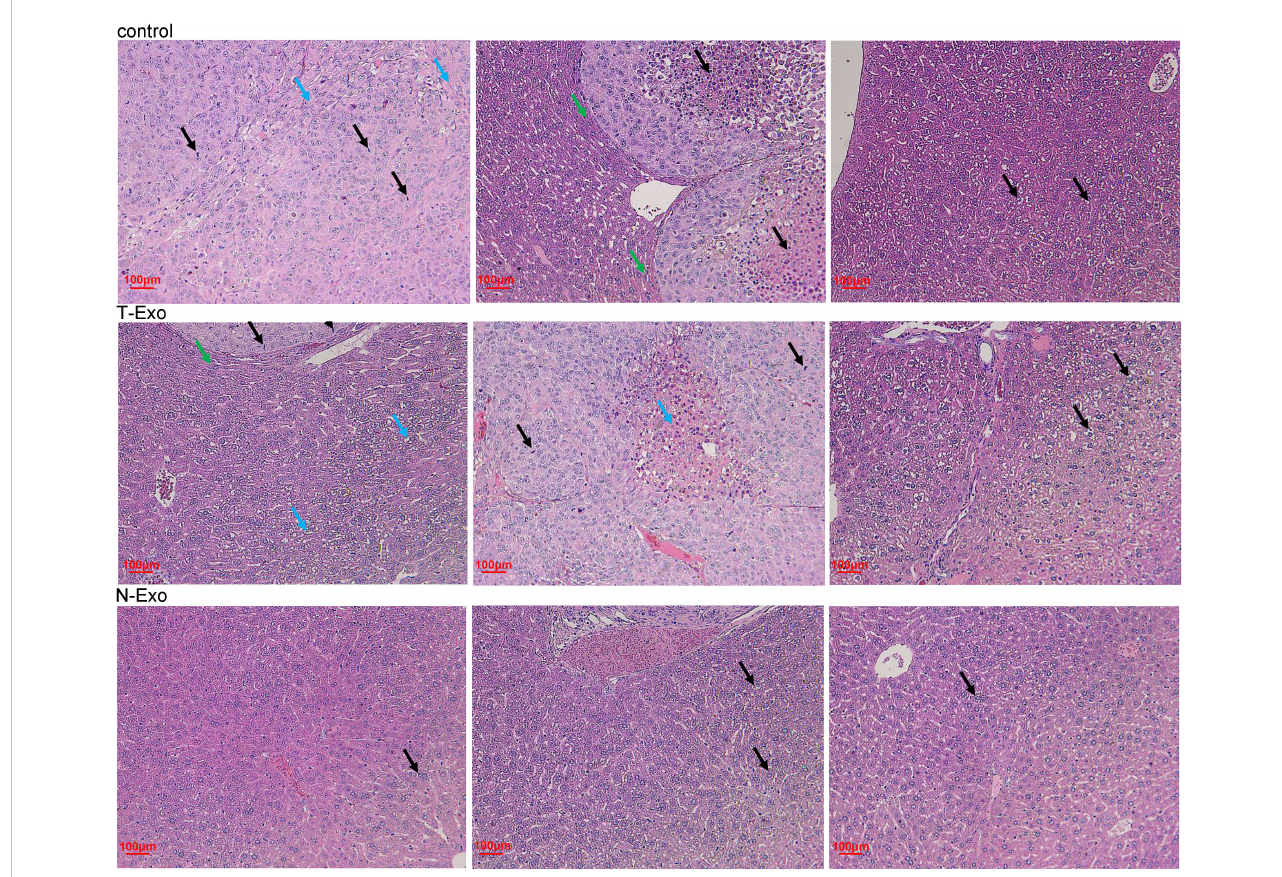
FIGURE 3 Representative pictures of hematoxylin eosin staining of liver tissues in the mice with different treatments. Black arrow: hepatic cells; blue arrow: fi brous hyperplasia; green arrow: peripheral hepatocyte cords. T-Exo: plasma-derived exosomes from thin camels; N-Exo: plasma-derived exosomes from normal